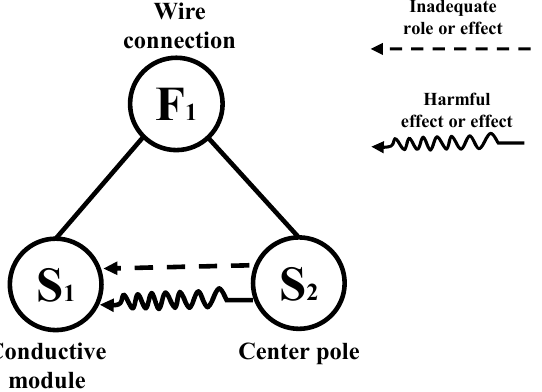
Figure 12. Object–field model of the conductive module.